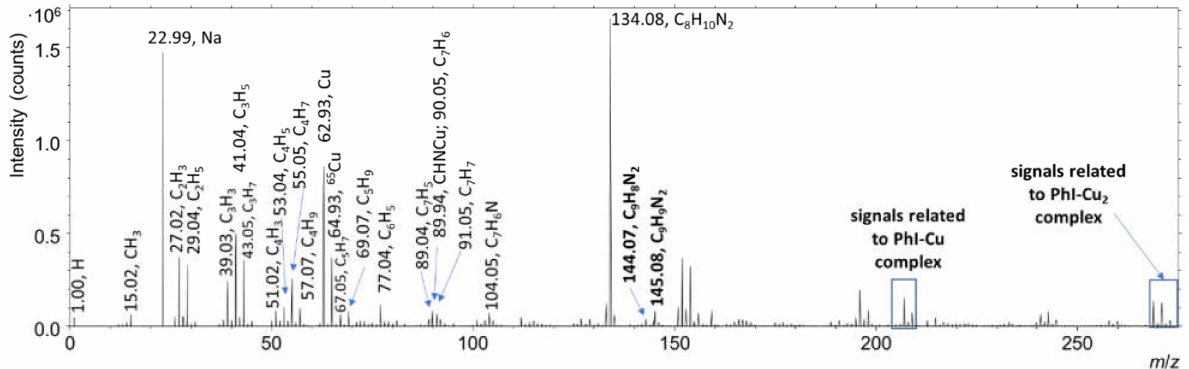
Figure 5. The positive ion ToF-SIMS spectrum for 2PhI-treated